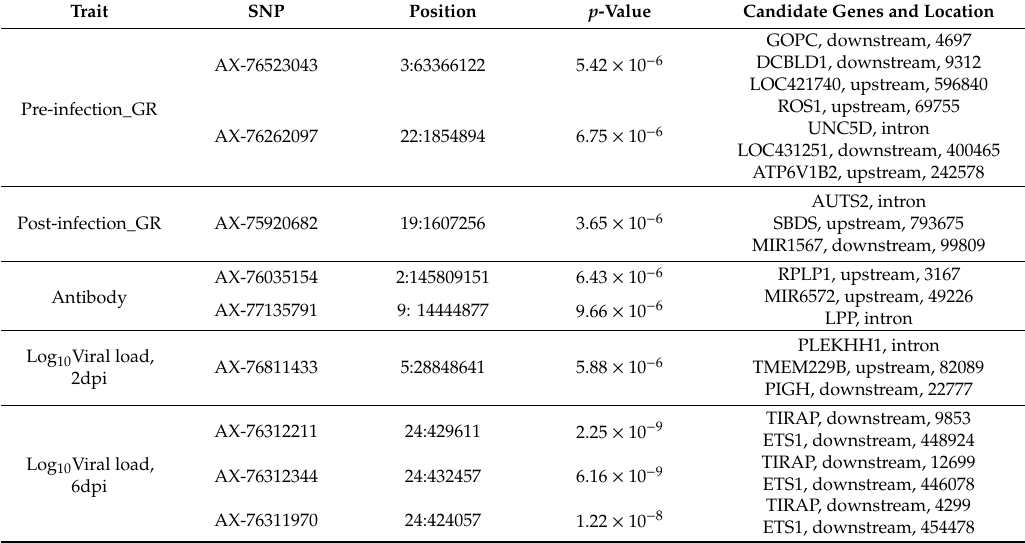
Table 4. Single nucleotide polymorphisms (SNPs) associated with NDV response traits based on genome-wise significance and positional candidate genes.